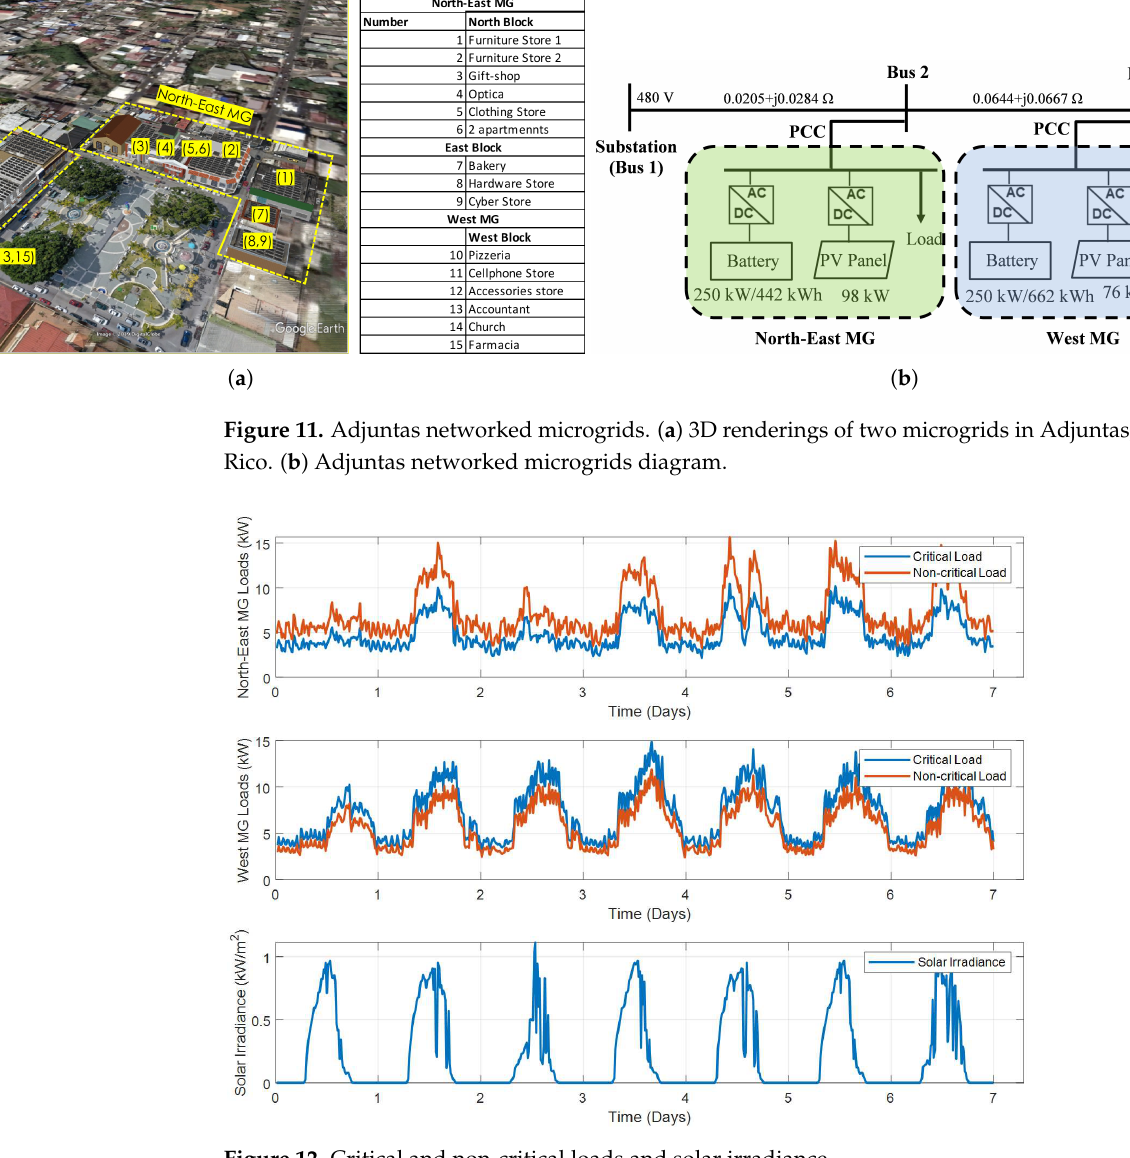
Figure 12. Critical and non-critical loads and solar